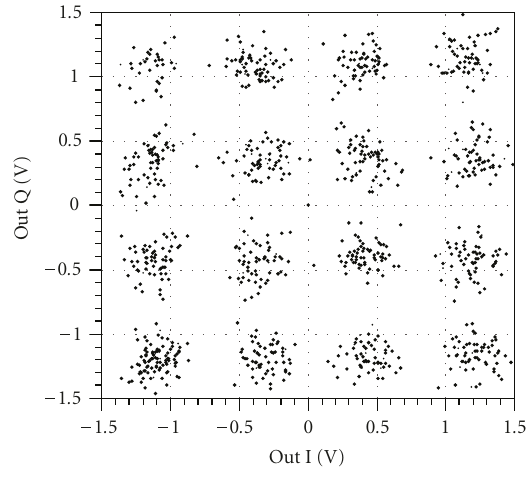
Figure 15: Constellation of demodulated 16 QAM signal in pres- ence of a white